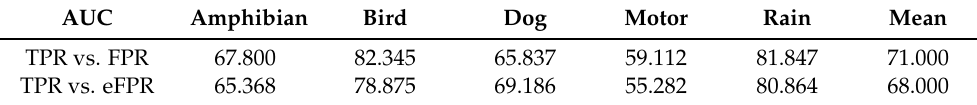
Figure 12. The PSD-ROC curves for TPR vs. FPR ( left ) and TPR vs. eFPR ( right ) per events. Table 3. Areas under the five PSD-ROC curves and the mean